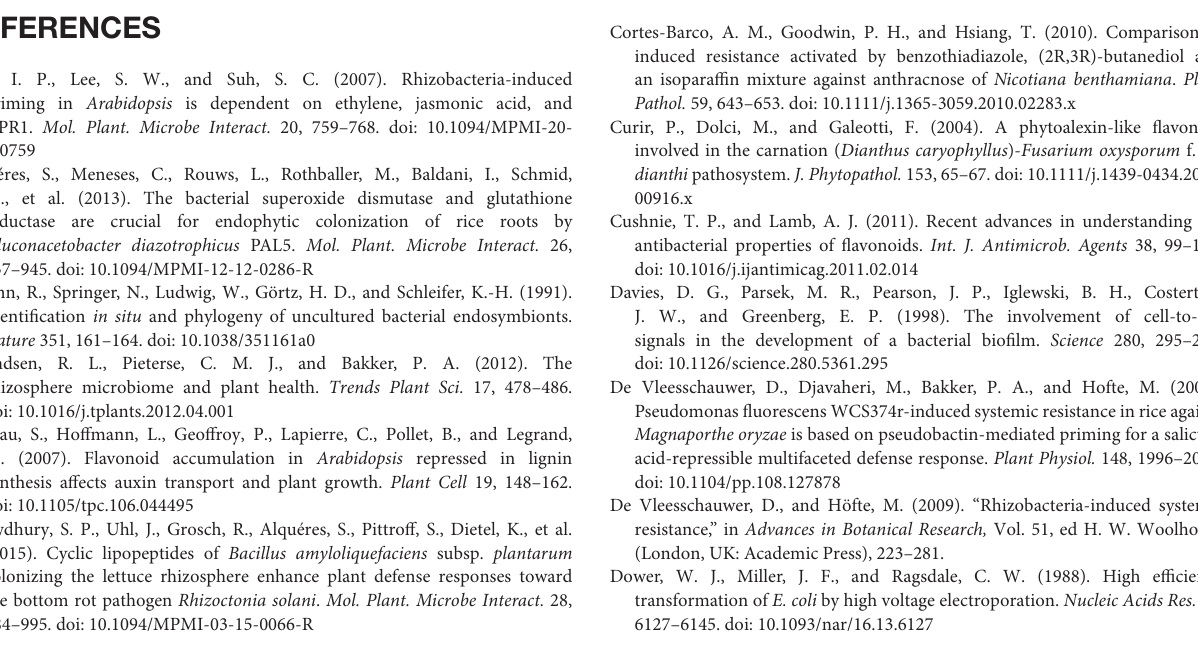
Figure S1 | Construction of araI mutant in A. radicis N35. Figure S2 | Colonization of barley roots by A. radicis N35 GFP in a monoxenic system at different time points after inoculation (dpi as indicated in the pictures). Figure S3 | Upper part: HPLC-separation of compounds with absorbance at 280nm (see MM). Lower part: UV-spectra of the different eluted compounds. Figure S4 | qPCR primer melting